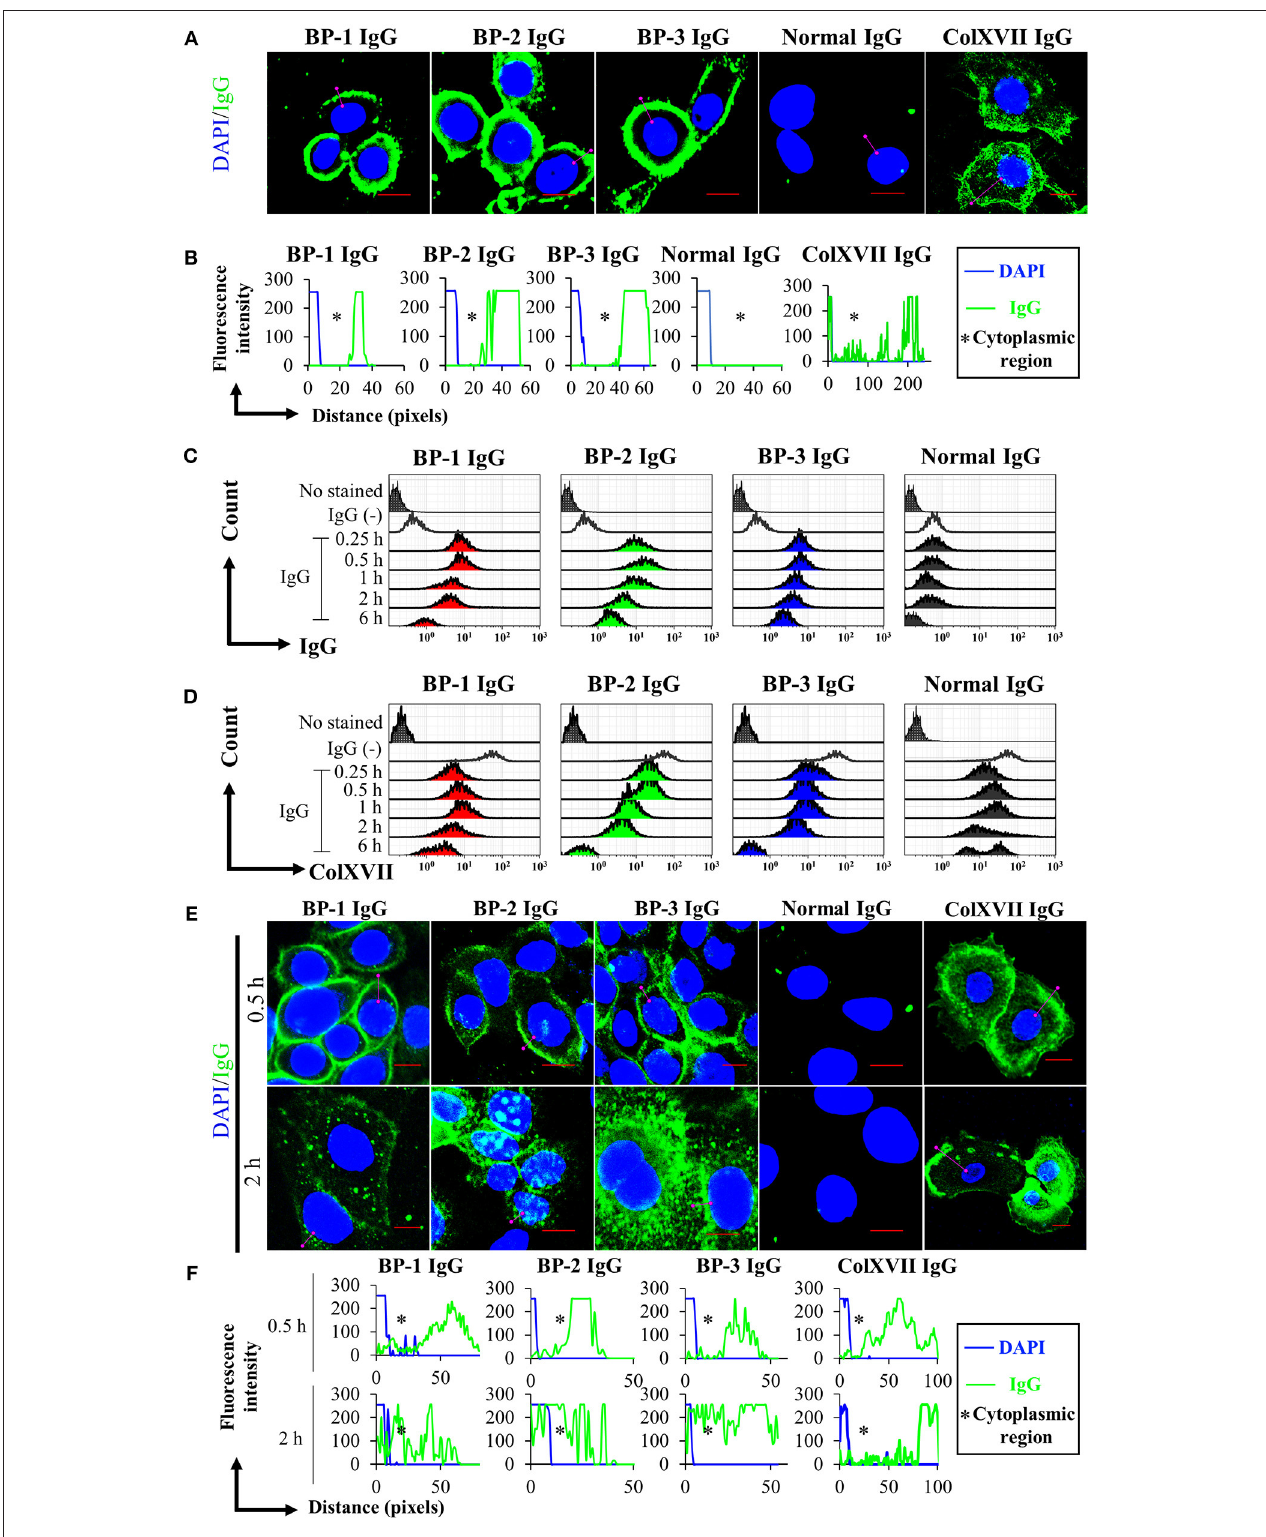
FIGURE 1 | Kinetics of the cell surface IgG binding and ColXVII expression. (A) Immunofluorescence staining for IgG bound to fixed NHEKs. NHEKs were fixed with paraformaldehyde and permeabilized. Cells were incubated with BP IgGs (BP-1, BP-2, or BP-3, 2 mg/ml), normal IgG (2 mg/ml), or rabbit anti-human